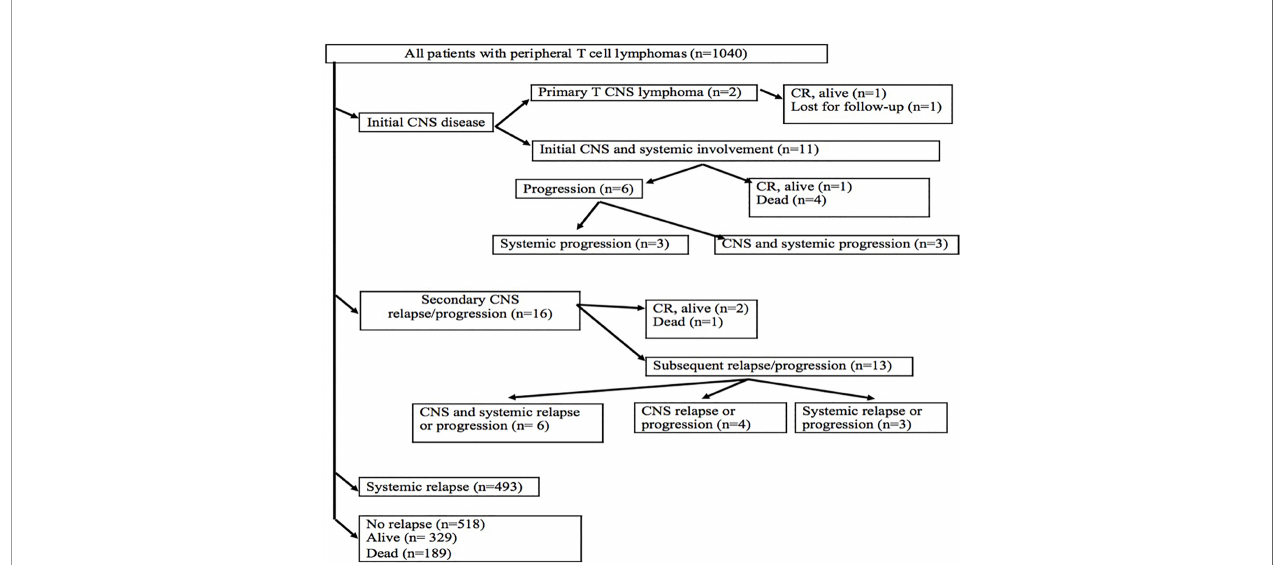
FIGURE 1 | Flowchart of patients with peripheral T-cell lymphomas. CNS, central nervous system; CR, complete